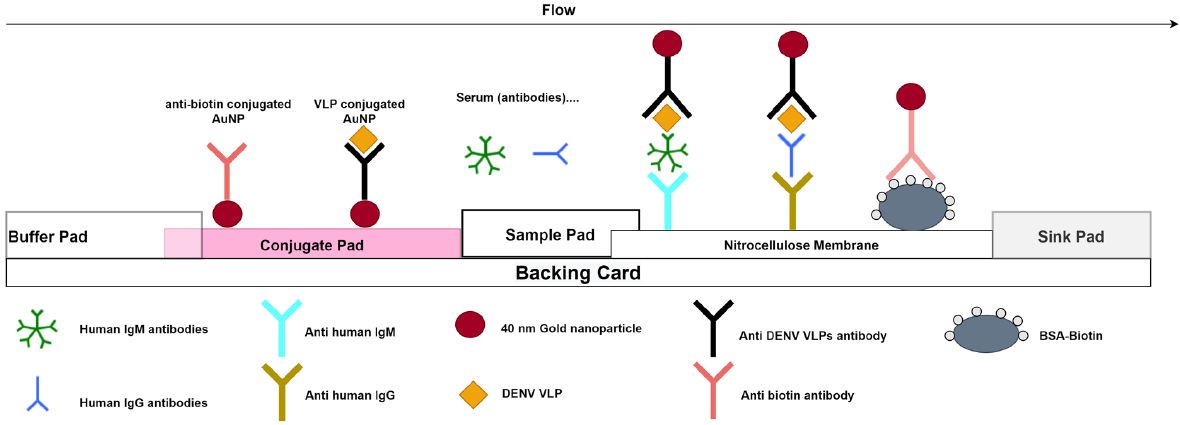
Figure 2. Schematic illustration of the Dengue IgM/IgG RDT test.